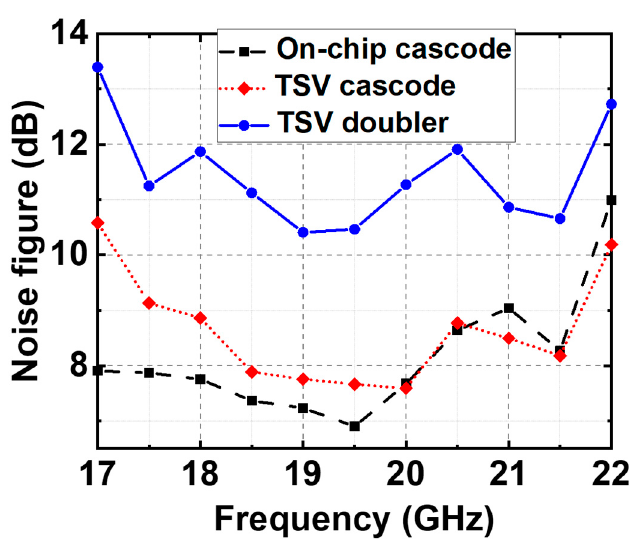
Figure 7. NF comparison between the proposed f T -doubler and conventional cascode RFAs.